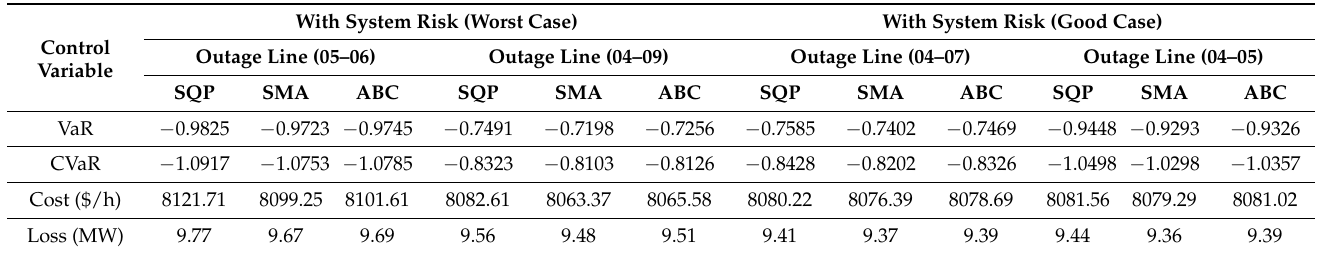
Table 2. Optimal cost and loss values with considering system risk for IEEE 14-bus